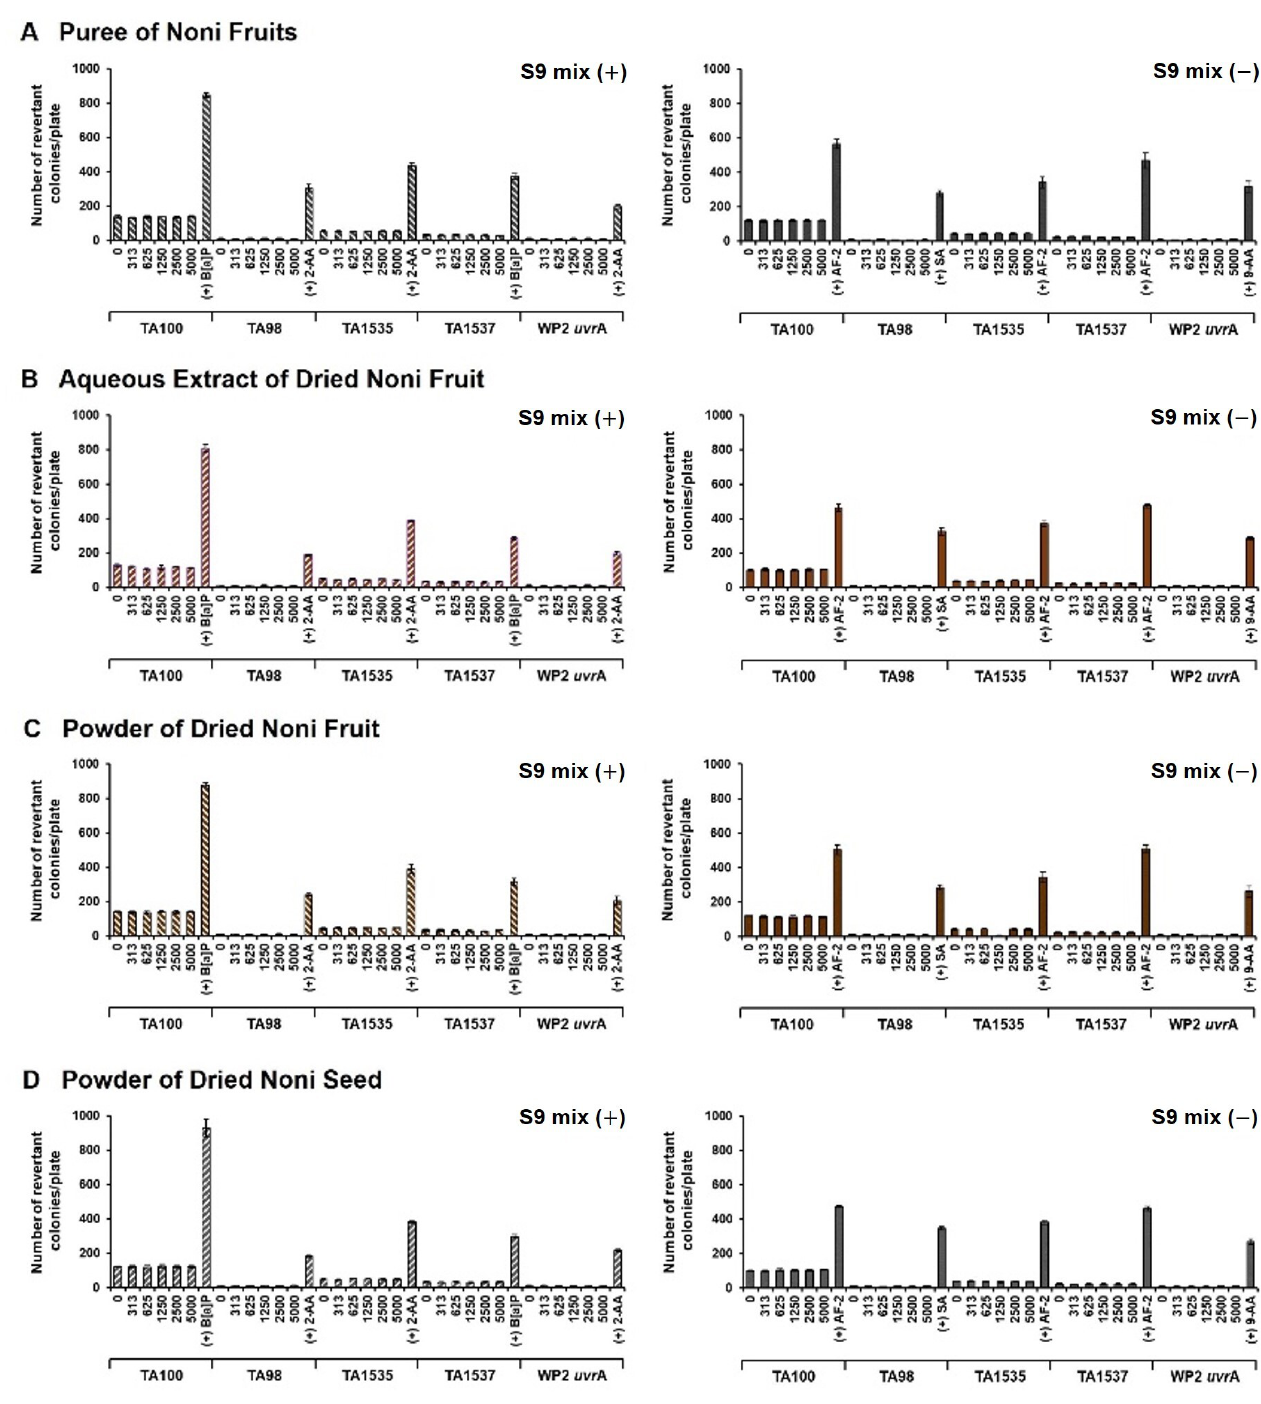
Figure 2. Summary of the Ames test of noni fruit preparations in Salmonella typhimurium (TA98, TA100, TA1535, and TA1537) and Escherichia coli (WP2 uvrA) in the presence or absence of S9 mix. All doses of each substance and the control were analyzed in triplicate.